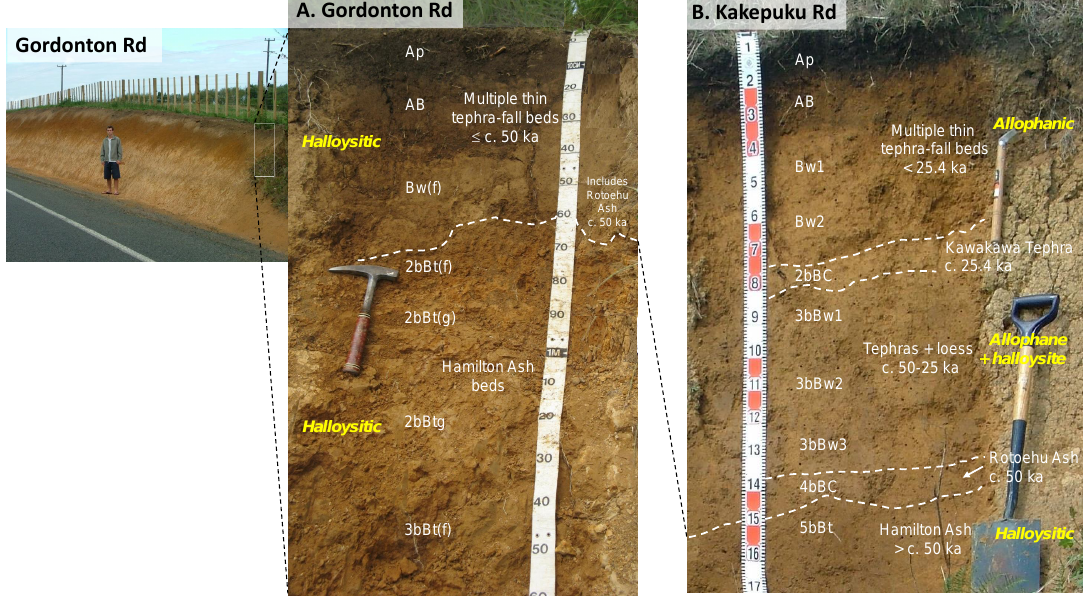
Figure 8. ( A ) Profile of the Kainui silt loam at Gordonton Road (37 ◦ 42 (cid:48) 23” S, 175 ◦ 18 (cid:48) 18” E), elevation c. 30 m asl, comprising two distinctive parts separated by a lithological discontinuity (dashed line). The soil has a thermic soil temperature regime but only just, being very close to mesic [34]. Formed by developmental upbuilding pedogenesis, each component of the upper profile has previously been an ‘A’ horizon whilst the land surface has risen slowly since c. 50 ka as thin tephras were accreted at the site at a mean rate of c. 1.2 mm/century. Redoximorphic features in the moderately well drained Bw(f) horizon (>2% Mn-Fe concretions with some MnO 2 coatings or mangans) indicate prolonged periods near to saturation because of perching on the buried paleosol marked by the 2bBt(f) horizon. Consequently, the entire soil is dominated entirely by the 1: 1 kaolin-subgroup clay mineral, halloysite, not allophane (an aluminosilicate nanomineral), because of limited desilication (see text). Annual rainfall at this site is c. 1200 mm/yr. The soil horizonation nomenclature used here and in other figures is based on [46]. The prefix ‘b’ is used to denote an identifiable soil horizon with pedogenic features developed before its burial. (In NZSC, ‘b’ is a prefix; in ST, it is a suffix.) The soil is a Buried-granular Yellow Ultic Soil in NZSC [11] and a Typic Kandiudult in ST [34]. A commercial tea plantation nearby is located in part on soils essentially identical to this one (Figure 4). Photo: R. McEwan. ( B ) Profile of the Otorohanga silt loam (of the Otorohanga series, referred to as ‘Otorohanga soil’ elsewhere in text) exposed on the low-angle shoulder of near-level summit in rolling hills at a site on Kakepuku Road (38 ◦ 03 (cid:48) 58” S, 175 ◦ 16 (cid:48) 43” E), c. 25 km south of the Gordonton Road site (Figure 1). The soil is at an elevation of c. 57 m asl and has a mesic soil temperature regime [34]. The upper 1.5 m comprises essentially the same late Quaternary tephras (dating back to c. 50 ka) that occur at Gordonton Road (Figure 8A) but their moderately greater thicknesses and hence greater depth to the buried clayey and less-permeable soil horizon (5bBt) on Hamilton Ash, together with a slightly higher annual rainfall (c. 1400 mm/yr) and somewhat greater (but still subordinate) andesitic tephra component [18,36], ensure that the upper soil has remained well drained with strong desilication and high Al, thereby favouring the formation of allophane [18,59,110,134] (see also text). The mean rate of accumulation of post-Rotoehu-Ash tephras (plus minor tephric loess) at this site is only c. 2.8 mm/century but it is more than twice the rate at Gordonton Road and a markedly different soil has ensued. The formation of allophane and the clustering of its constituent tiny spherules into micro- and nanoaggregates [135], generating high porosity and low bulk density [110], is self-reinforcing by enhancing matrix-flow drainage and promoting further desilication. The soil reflects developmental upbuilding pedogenesis, most parts of the profile being an ‘A’ horizon at some point. It is a Typic Orthic Allophanic Soil in NZSC and Typic Hapludand in ST [11,34]. Photo: D.J.